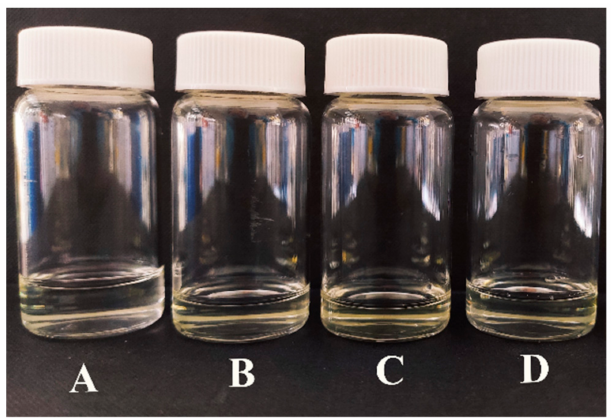
Figure 3. Microemulsions formulated in this study: blank control solution without EOs ( A ); C. marittimum -ME ( B ); C. cyminum -ME ( C ); P. anisum -ME ( D ). The formulated EO-MEs (5% w / w ) are limpid and transparent and, in some cases, with a slight yellowish